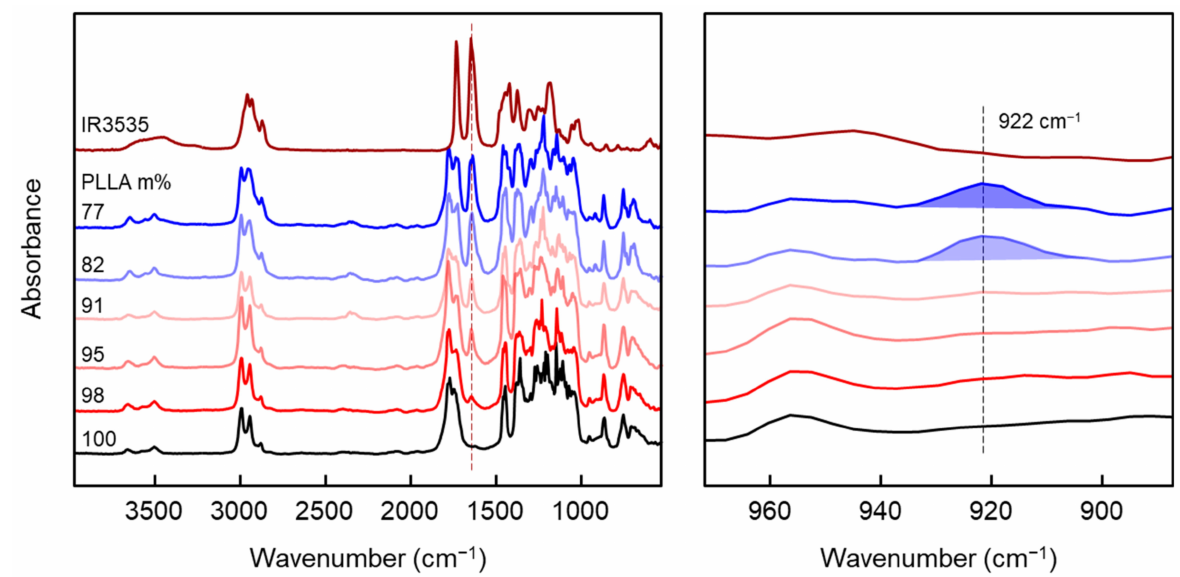
Figure 5. FTIR spectra of PLLA/IR3535 extrudates stored at room temperature for 6 months ( left ). The right plot shows details in the wavenumber range of 890 to 970 cm − 1